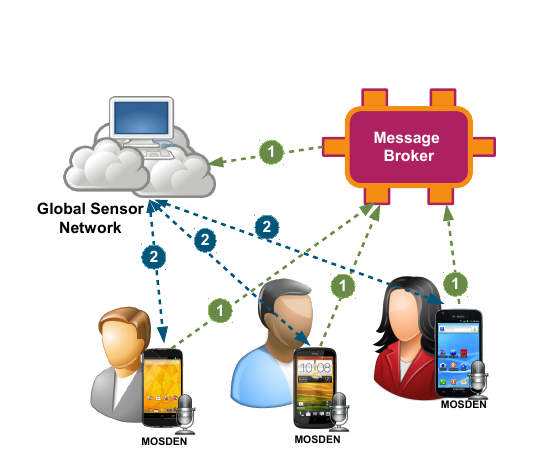
Figure 4. Implementation of Opportunistic Sensing Application using